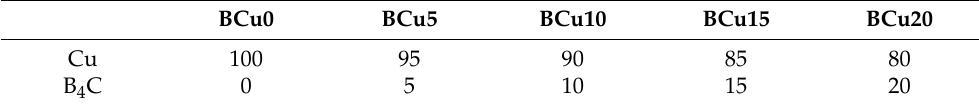
Table 1. The specimen numbers of the B 4 C/Cu composites and their corresponding components (wt.%).